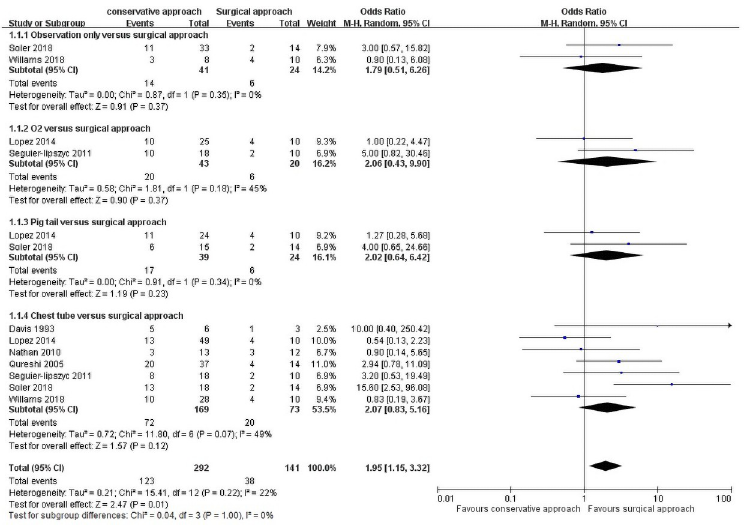
Fig 2. Recurrence rate of conservative approaches versus surgical approach as first-line management.